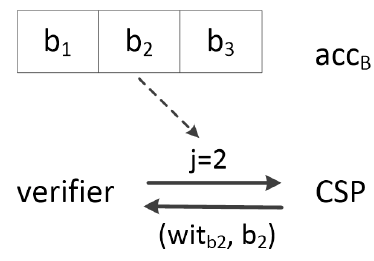
Figure 3. An illustrative Figure 3 . An illustrative example.